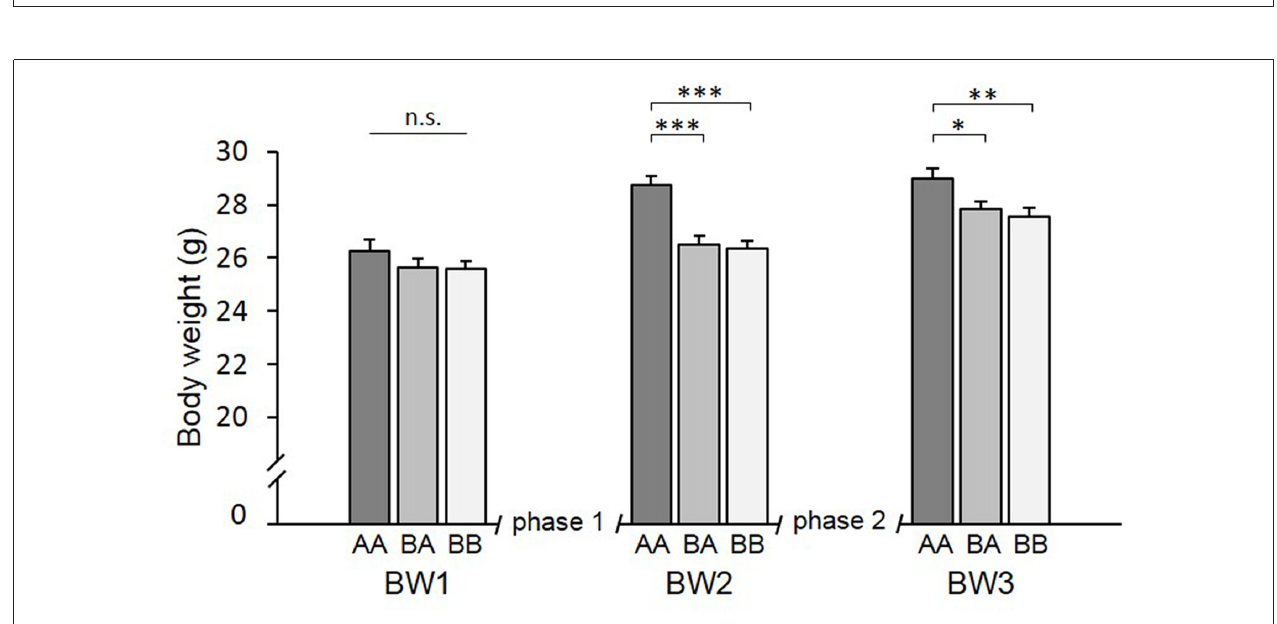
FIGURE 5 | Body weight (BW). Adult male mice were provided with two experimental phases (phase 1 and 2), during which they either experienced benefits followed by escapable adversity (BA group) or throughout adverse (AA) or beneficial conditions (BB), respectively. BW was assessed before phase 1 (BW1, PND 71), between phase 1 and 2 (BW2, PND 100) and at the end of phase 2 (BW3, PND 114). There was a significant effect of time and experience as well as an interaction between these two factors. Data are presented as means ± SEM. Statistics: repeated measures ANOVA; post hoc : Bonferroni; sample sizes: n BA = 11, n AA = n BB =